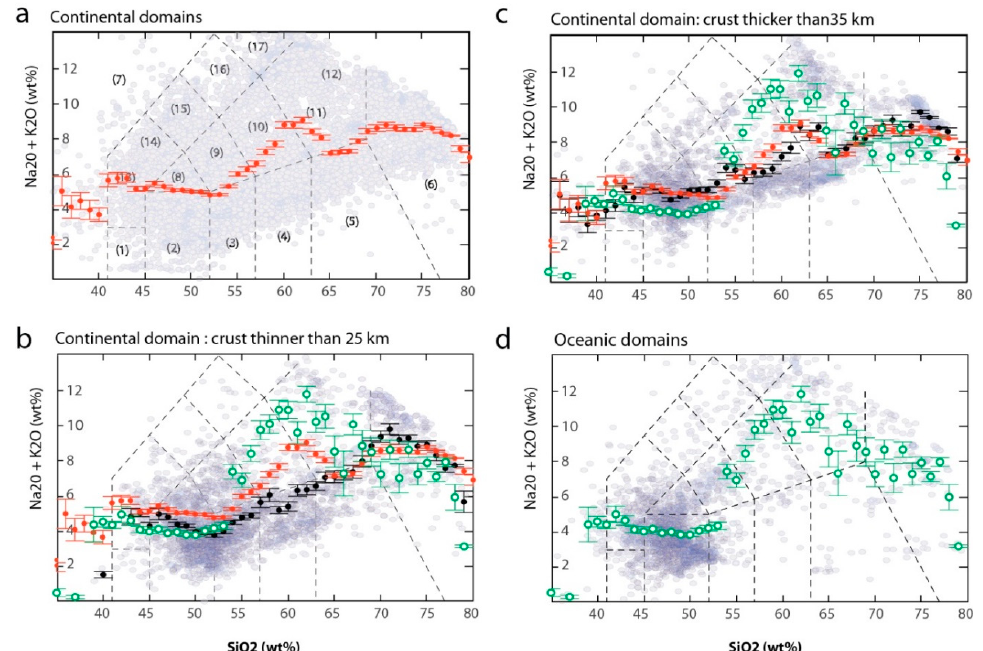
Figure 8. ( a , d ) Correlation between the gradual occurrence or decrease (statistical assessment) of alkali magmas in the oceanic (green dots) and continental s.l. (red dots) records. The alkalinity of magma (grey points) is given by the relative proportion of Na 2 O + K 2 O mass percent (wt%) of rocks throughout their SiO 2 evolution (total-alkali content versus silica diagram: TAS diagram). Bootstrapping of the total-alkali content reveals a positive correlation between [Na 2 O + K 2 O] and SiO 2 in the more evolved composition of magmas (SiO 2 > 50 wt%). ( b , c ) The black dots yield correlations between the gradual increase or decrease of alkali magmas occurrences in the continental record s.l. and the crustal thickness at the site of eruption. Bootstrapping of the total-alkali content reveals a negative correlation between [Na 2 O + K 2 O] and SiO 2 in the less evolved (basaltic) composition of magmas (SiO 2 45–52 wt%).